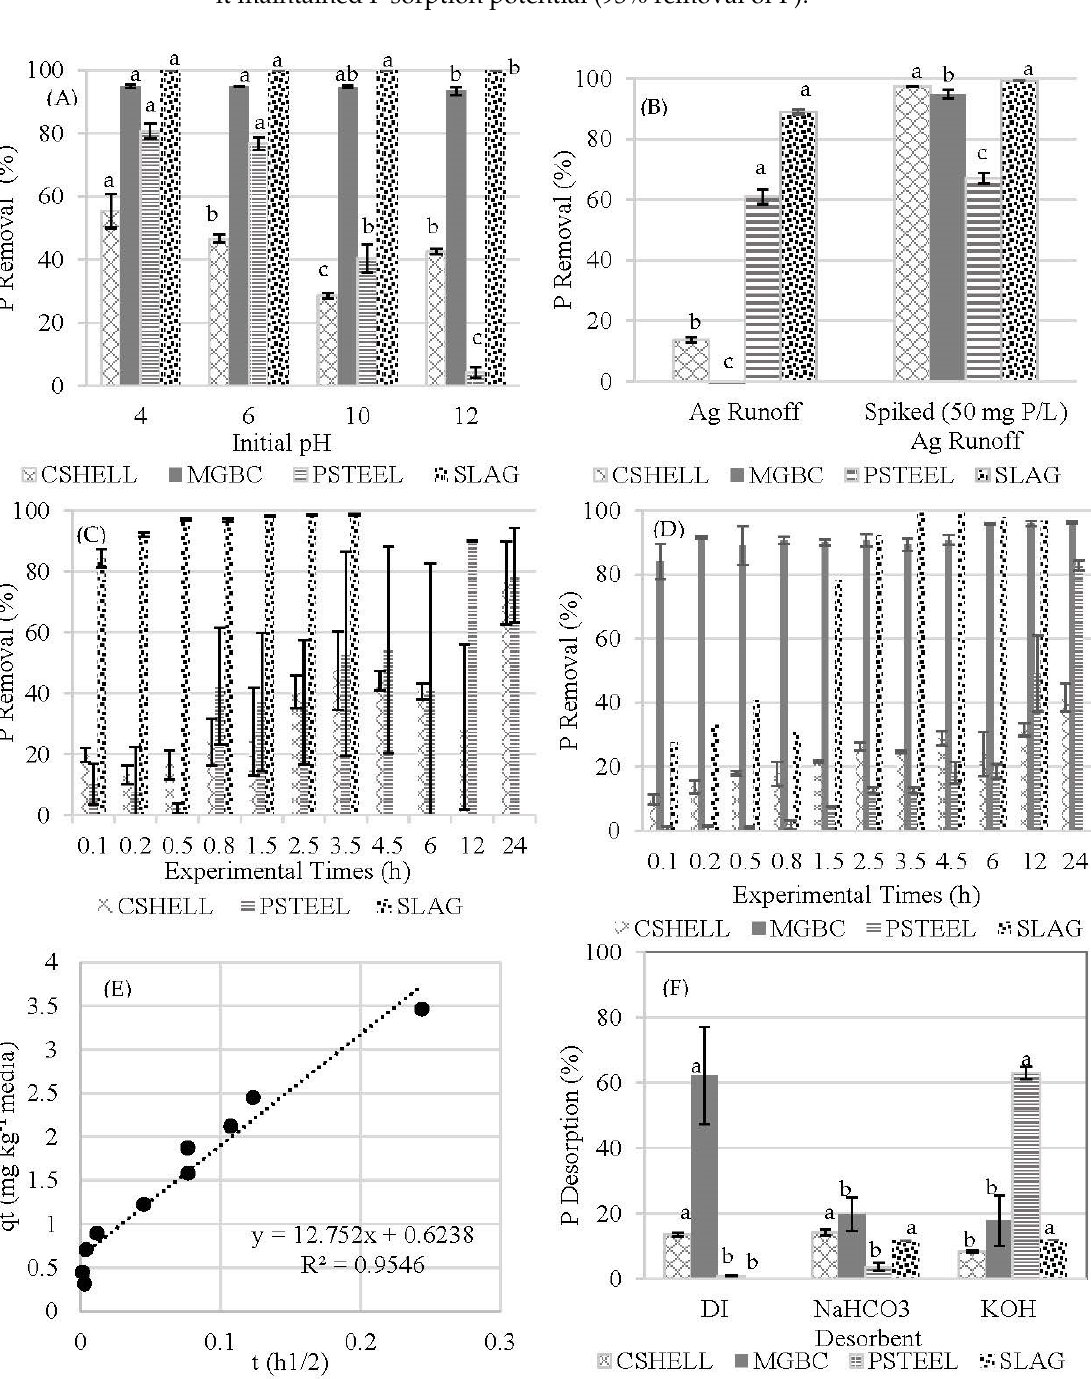
Figure 4. Batch sorption testing: ( A ) impact of pH; ( B ) agricultural runoff; ( C ) low P (2 mg P/L) concentration kinetics; ( D ) high concentration (50 mg P/L) kinetics; ( E ) intraparticle diffusion modeling of high concentration PSTEEL trial; ( F ) sequential desorption (DI, sodium bicarbonate, and potassium hydroxide) of media collected from 50 mg P L − 1 batch isotherm trials. P removal between pH values for individual treatments with similar letters (a, b, and c) did not show statistical significance at the α = 0.05 level. Desorption between extractants for individual treatments with similar letters (a, and b) did not show statistical significance at the α = 0.05 level. P removal from agricultural runoff between treatments with similar letters (a, b, and c) did not show statistical significance at the α = 0.05 level.